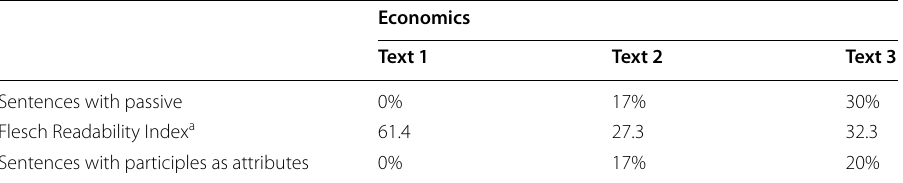
Table 2 Reading texts: indicators of